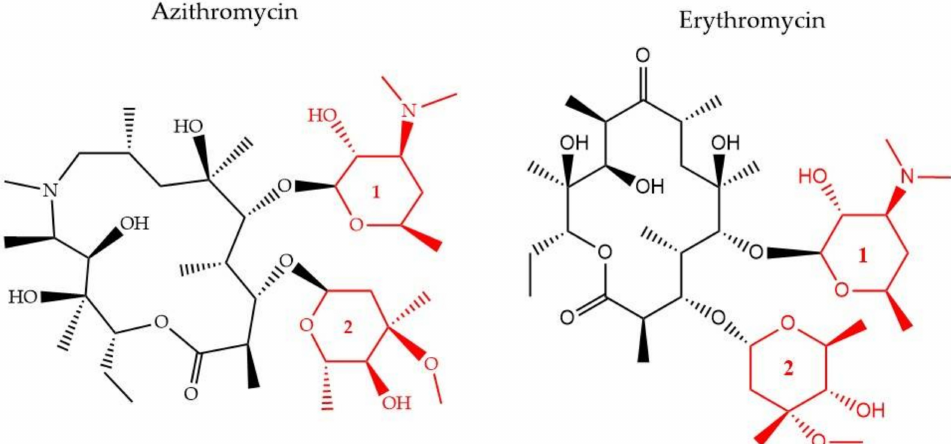
Figure 4. The chemical structure of two antibiotics, azithromycin, and erythromycin that belong to the macrolide class are shown. Conserved ring structures of sugars 1 and 2 ( red ) and varied lactone ring are